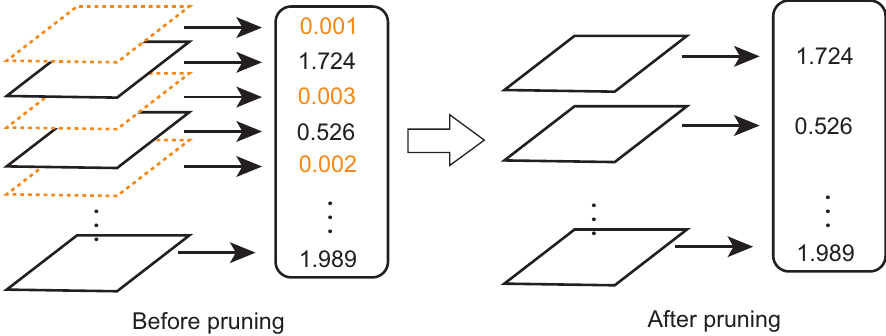
Figure 2. The network slimming process. The channels (left side in orange color) with small scaling factor values (the numbers in orange color) will be eliminated.